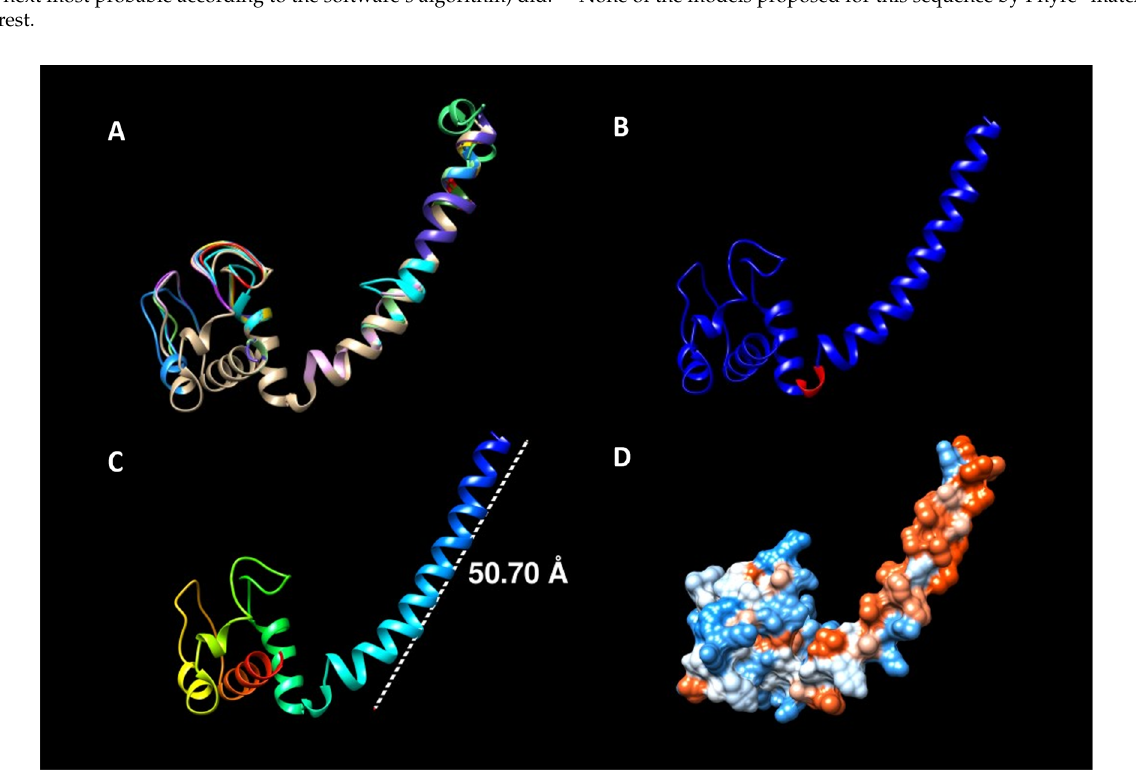
Figure 2. Visualization of the predicted 3D structures for Cyt c M . ( A ) shows the superposition of all the 15 predicted structures that coincided, each one displayed in the ribbon representation and bearing a different color. Among all the sequences that gave rise to the same structure, that of Nostoc sp. PCC 7120 was used as consensus model for ( B – D ), since its prediction had both the sequence with the highest coverage (92%) and the structure with the highest confidence index (99.8%). ( B ) displays in red the place where the VLA motif would be located, whereas ( C ) shows the length of the tail in a rainbow-colored model. ( D ) represents the hydrophobicity surface of the model with an orange-hydrophobic/blue-hydrophilic palette. Note the considerably more hydrophobic nature of the tail.